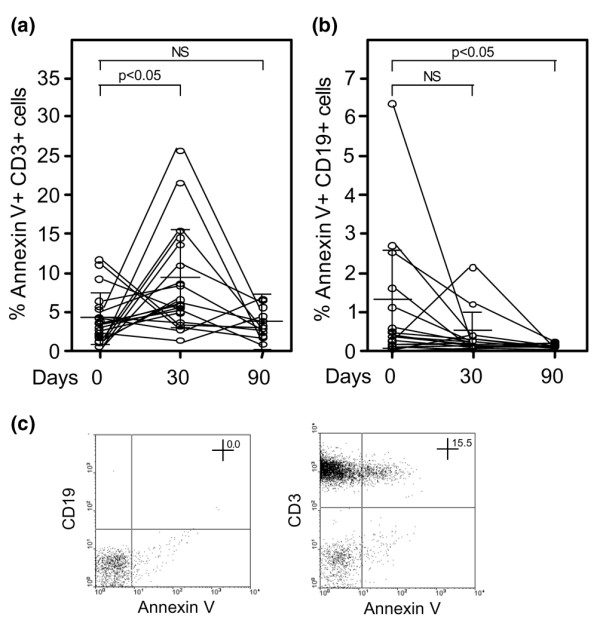
Analysis of apoptosis of subsets of peripheral blood mononuclear cells in patients with systemic lupus erythematosus under Rituximab therapy. Freshly isolated mononuclear cells from systemic lupus erythematosus patients were double labeled with annexin V-FITC plus antibodies specific for (a) T cells or (b) B cells, and analyzed by flow cytometry, as described in Materials and methods. As indicated, detection of apoptotic cells was performed before (day 0) and after (days 30 and 90) administration of Rituximab. The arithmetic mean is indicated with a horizontal line, and the standard deviation with a vertical line. (c) Representative histograms of flow cytometry analysis of CD3+ and CD19+ cells at day 30.